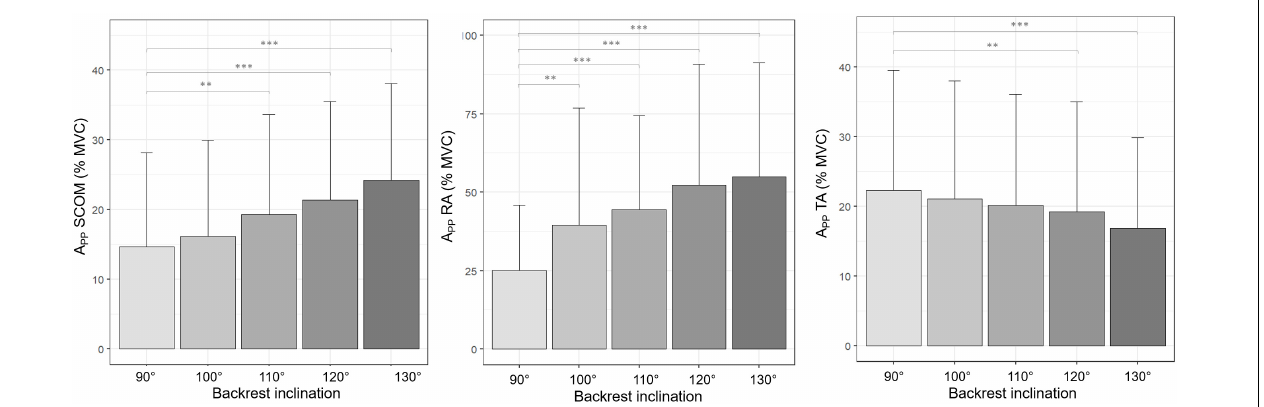
FIGURE 5 | Mean (SD) muscle activity levels in the postural phase (APP), in % MVC, for the 5 inclination conditions calculated for both execution speeds. Symbols for the p -values are as follows: ∗∗ p < 0.01; ∗∗∗ p < 0.001.